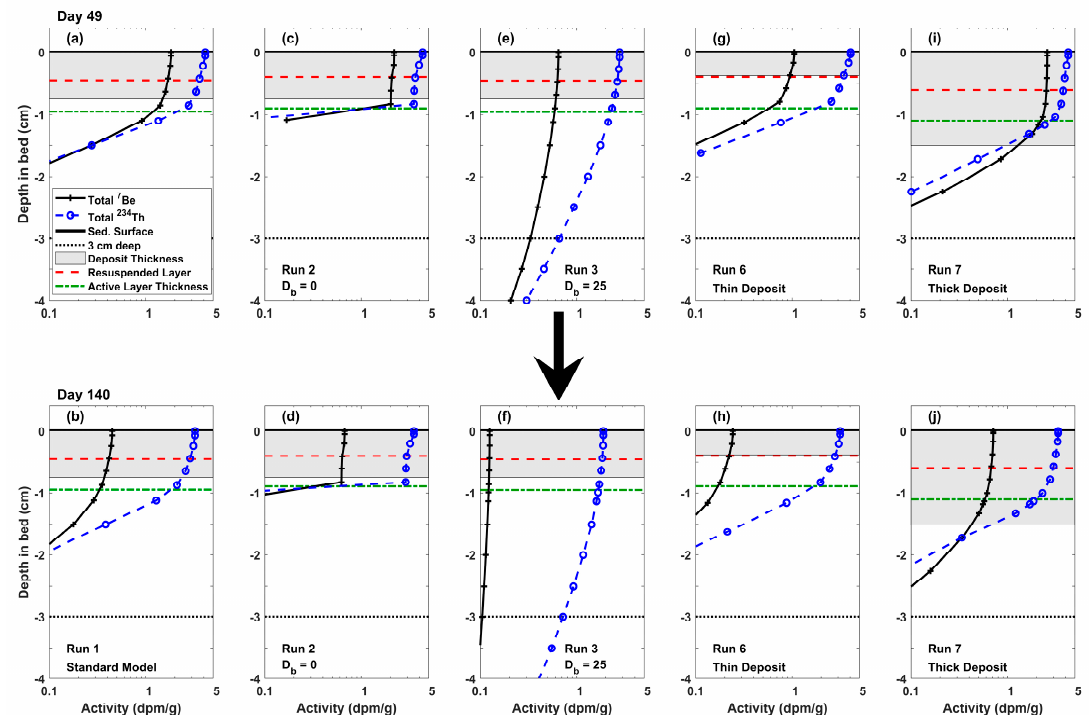
Figure 3. Vertical profiles of seabed radioisotope activities at four instances for Case 1. ( a ) Day 7 after initial deposition, ( b ) Day 39 at peak of a resuspension event, ( c ) Day 49 after redeposition, and ( d ) Day 140 during the extended quiescent period. Solid black lines represent bed surface and thick dashed lines represent three centimeters deep in the bed. The bed height prior to initial deposition was defined as z bed = 0.